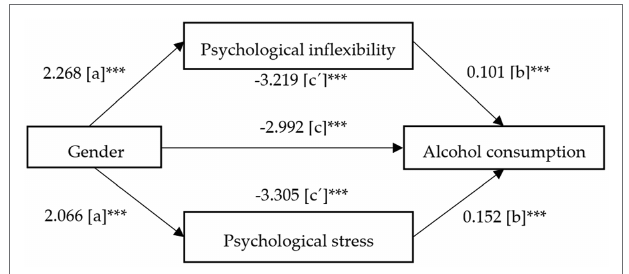
FIGURE 1 | Unstandardized regression coefficients for the mediation effect of (a) psychological inflexibility on the relationship between gender and alcohol consumption and (b) stress on the relationship between gender and alcohol consumption. *** p < 0.001.